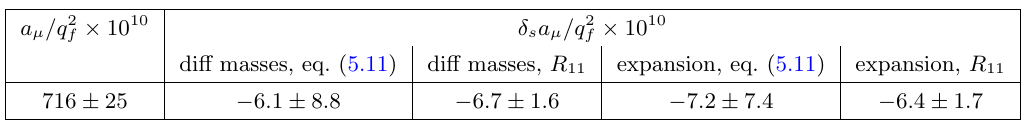
(cid:0) (cid:5) m u =q 2 to a (cid:22) calculated with f f